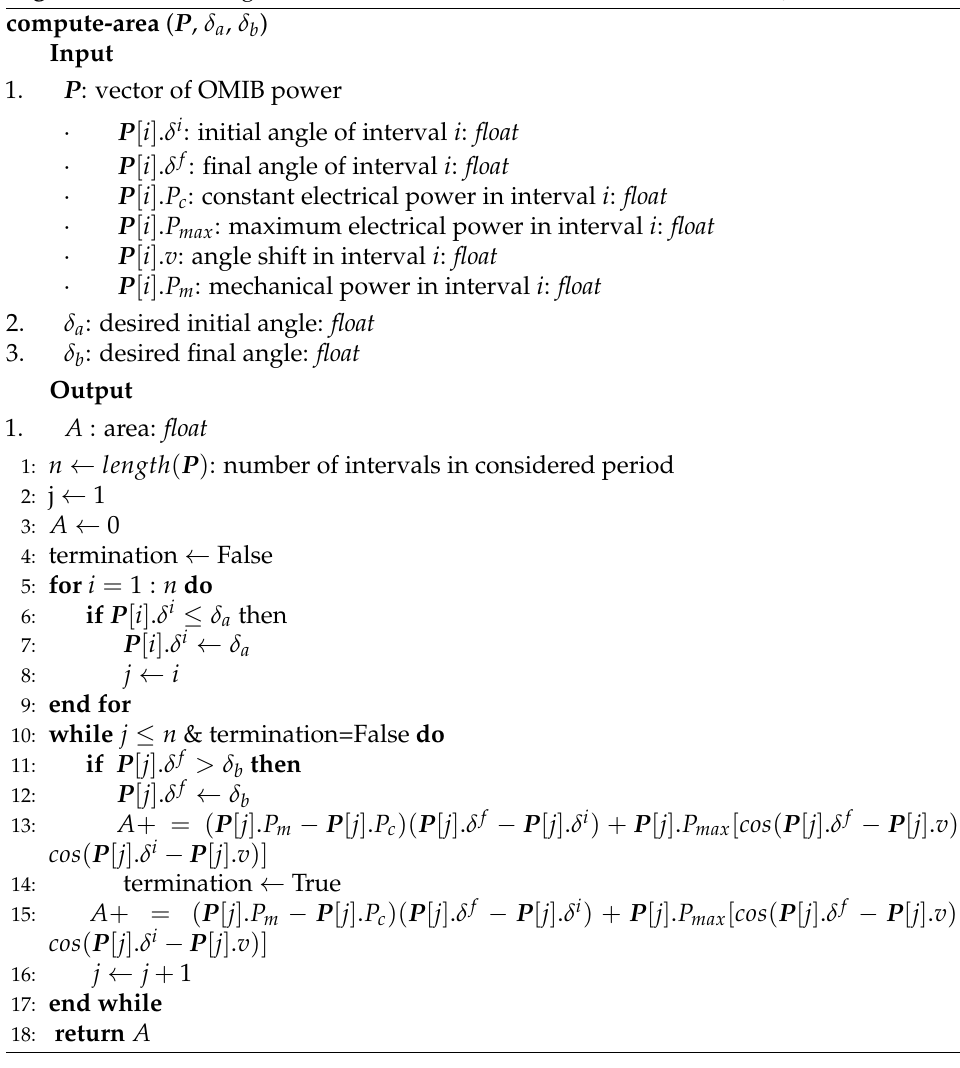
Algorithm A3 Finding the area between P m and P e for desired δ a and δ